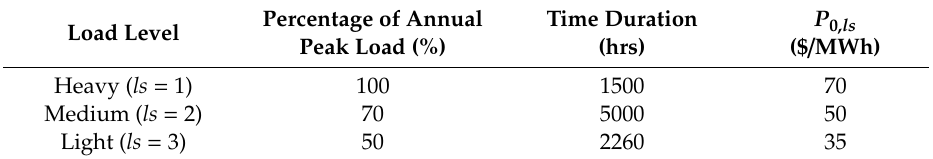
Table 3. The details of the load duration curve [26].